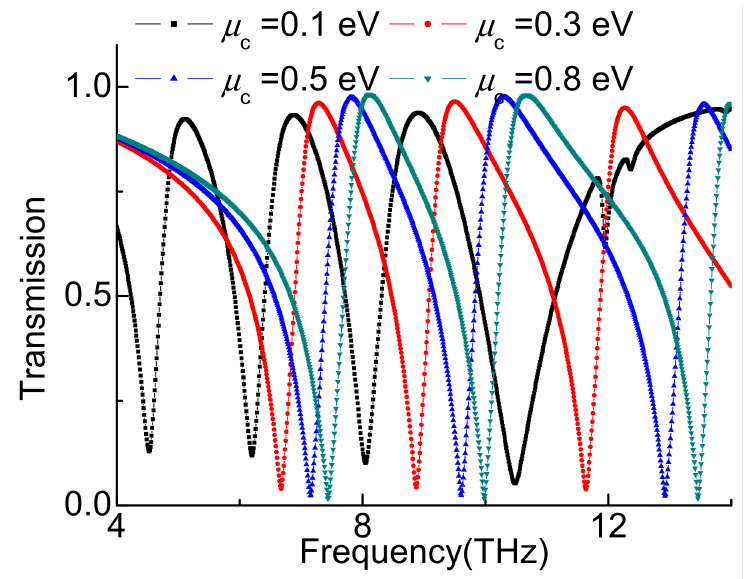
Figure 5. Transmission spectrum with different voltage of the